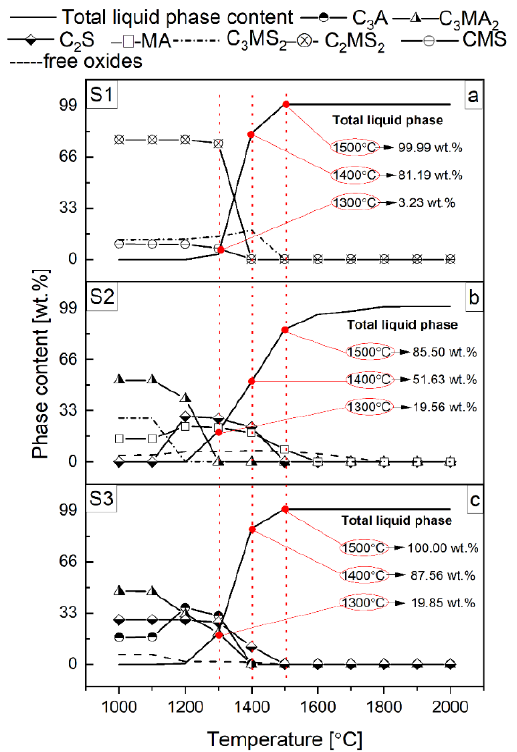
Figure 3. Thermodynamic predictions of the solid phases and liquid phase of the steel slags with the C/S mass ratio of 1.1_S1 ( a ), 3.5_S2 ( b ), 5.5_S3 ( c ), when exposed to an oxidizing atmosphere vs. an increasing temperature.